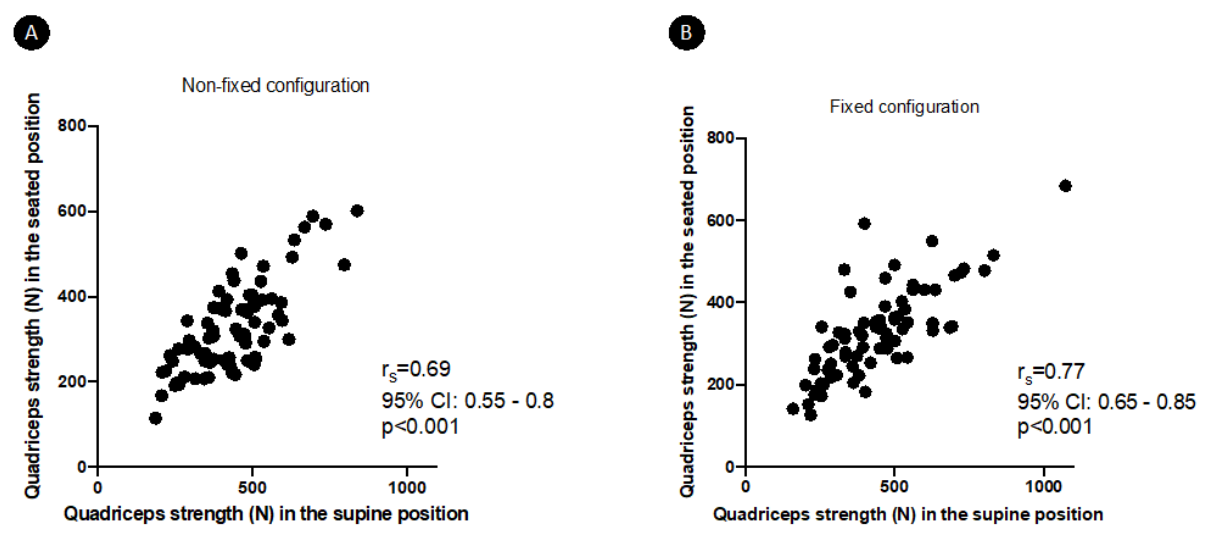
Figure 3. Correlations between quadriceps strength in the seated (H90-K90) and supine (H45-K40) positions, in non-fixed ( A ) and fixed ( B ) configuration.